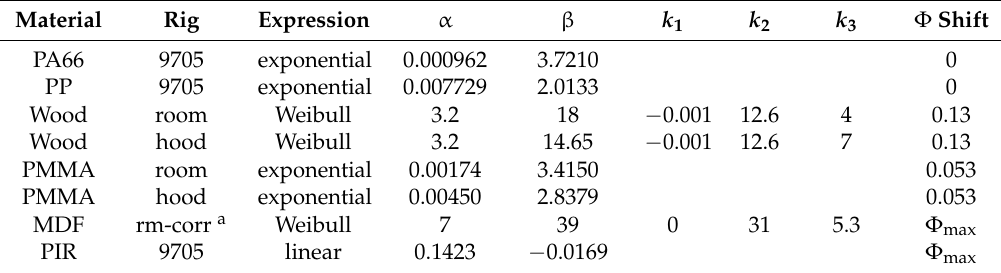
Table 4. CO (g/g) compartment fire yield expressions for all